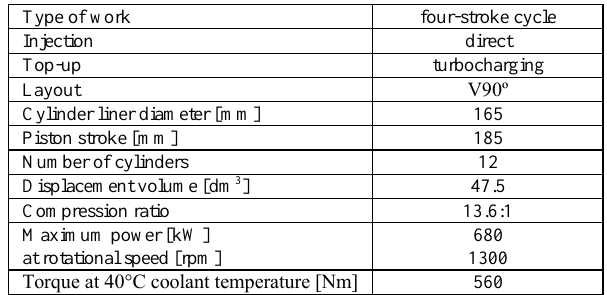
Table 4. Basic technical data of the research object (according to the operation and maintenance documentation [5])